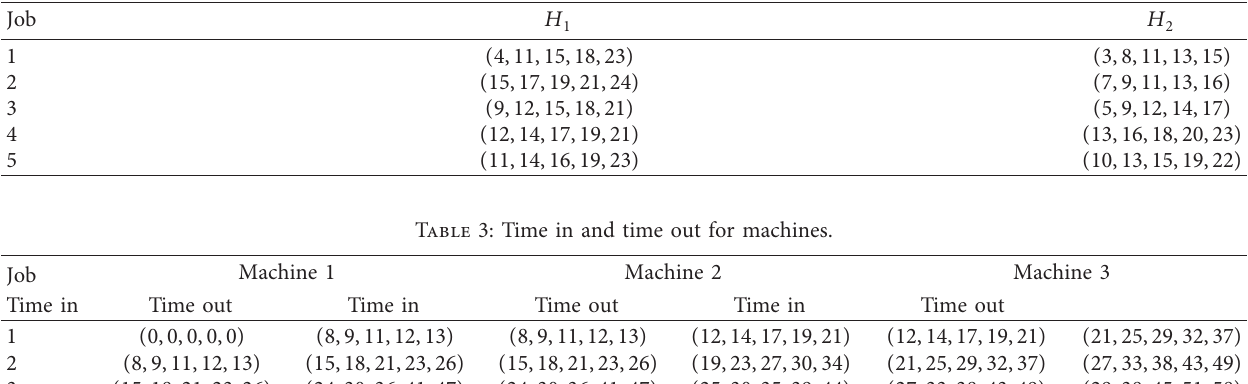
Table 1: Pentagonal fuzzy processing times 􏽥 A